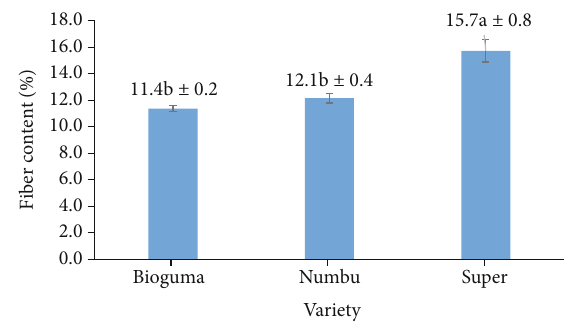
Figure 7: Dietary fi bre content of three varieties of polished sorghum grains.